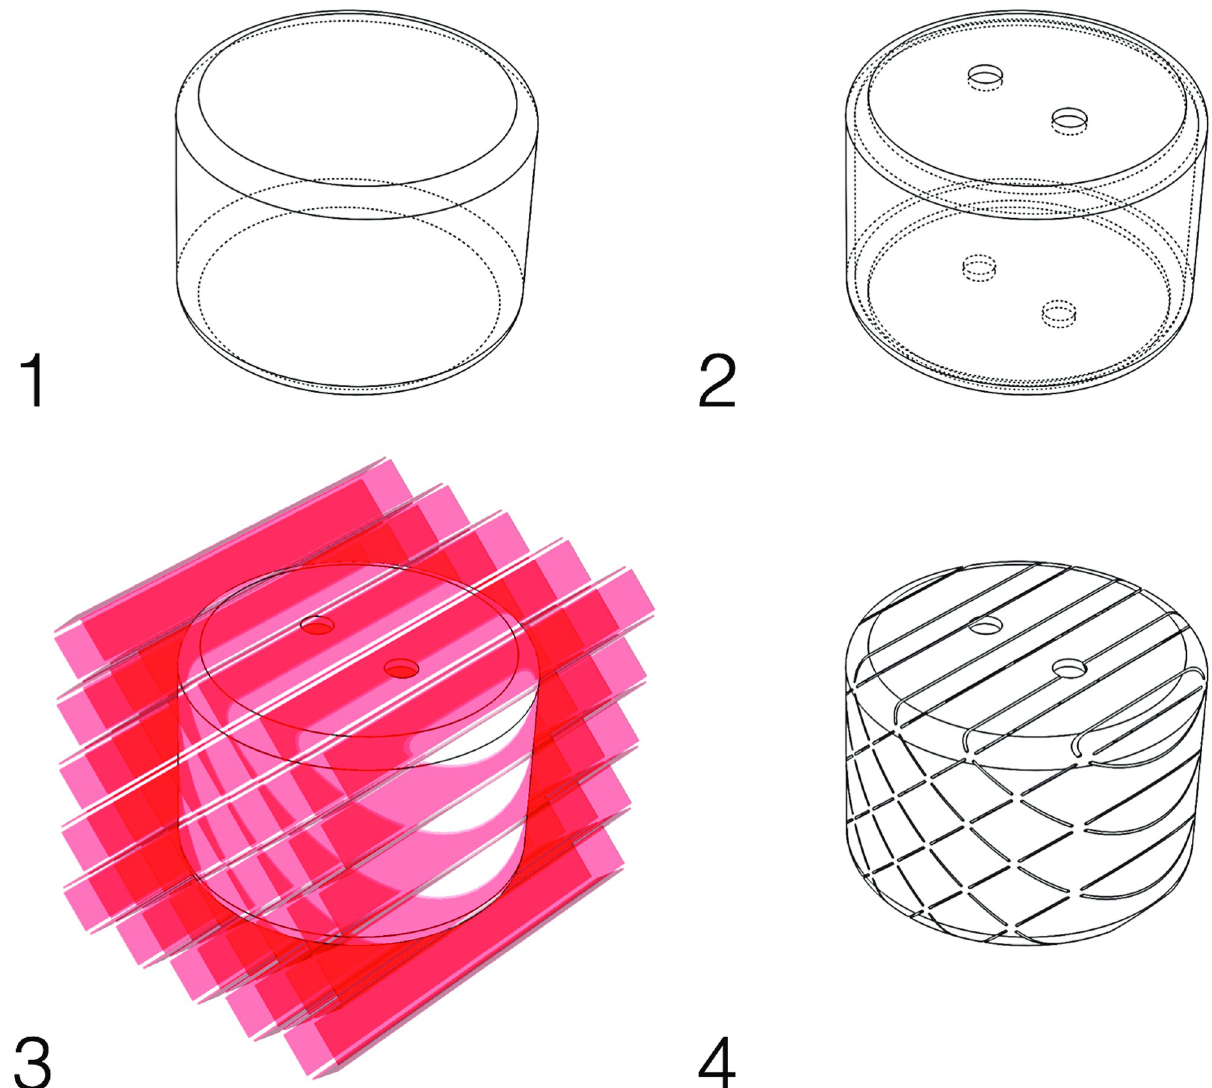
Fig 3. Creating a negshell core in CAD. 1: The solid model representing the core. 2: The core is hollowed to a 0.4 mm shell. 3: Cutting the cross-hatch pattern into the hollowed core. 4. The final negshell core ready for 3D printing.